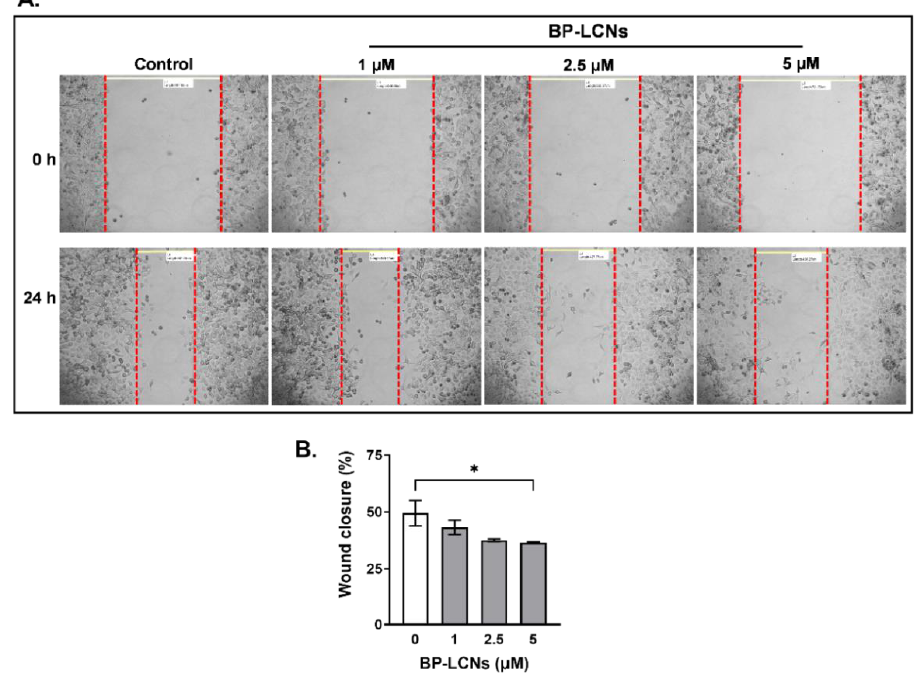
Figure 9. Effect of BP-LCNs on migration of A549 cells. A549 cells were grown in a 6-well plate until confluency. The wound was created by scratching the cell monolayer with the tip of a sterile pipette. The cells were then incubated at 37 °C for 24 h in the absence or presence of BP-LCNs (final concentration 1, 2.5, or 5 µM). Images were taken using a phase contrast microscope with an objective lens of 10× magnification at 0 h and 24 h of incubation with or without BP-LCNs ( A ). The wound closure (%) was quantified by comparing the widths of the wound at 0 h and 24 h for each well ( B ), as explained in the Materials and Methods section. The values in ( B ) represent means ± SEM of 3 independent experiments. Note: * p < 0.05. Abbreviation: BP-LCNs, berberine–phytantriol liquid crystalline nanoparticles.